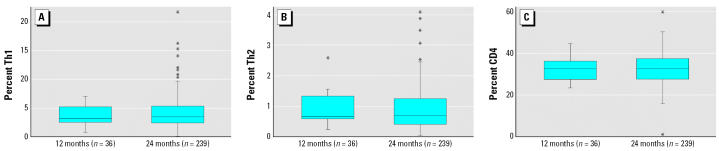
Th1 (A), Th2 (B), and CD4 (C) levels in CHAMACOS children at 12 months (n = 36) and 24 months (n = 239) of age.